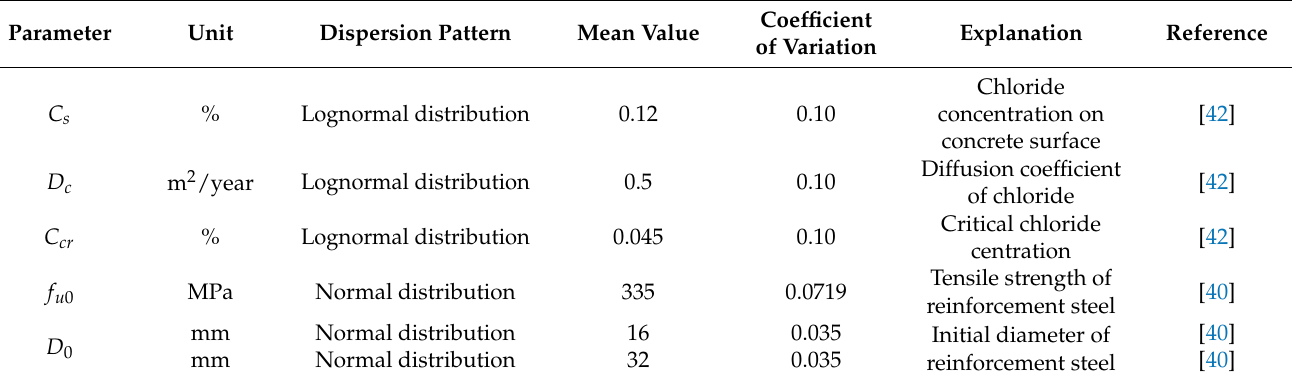
Table 2. Probability distribution and statistical parameters of influencing factors of simply supported T-beam